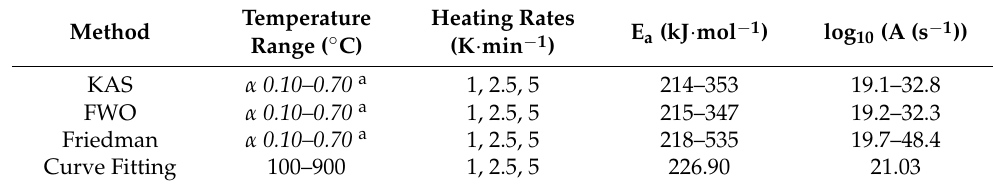
Table 1. Arrhenius parameters for the non-catalytic degradation of wheat straw (WS) taken from the work of Lopez et al. [36].